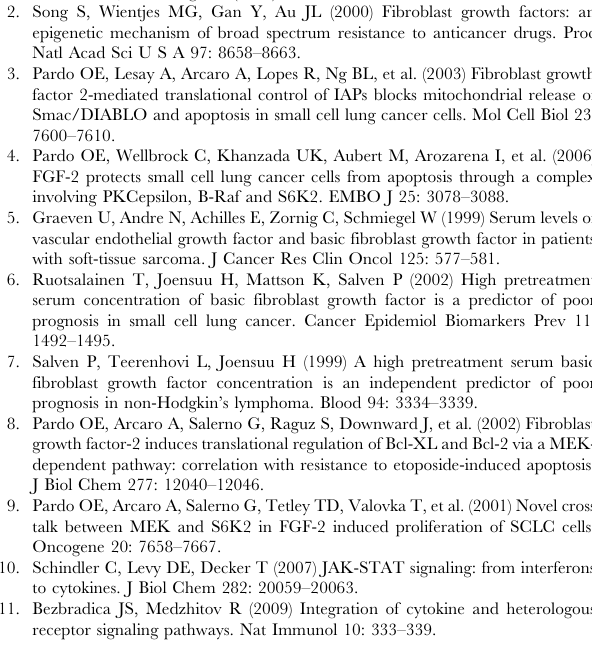
independent experiments are shown in the graph. Values are expressed as fold change over untreated controls. Statistical